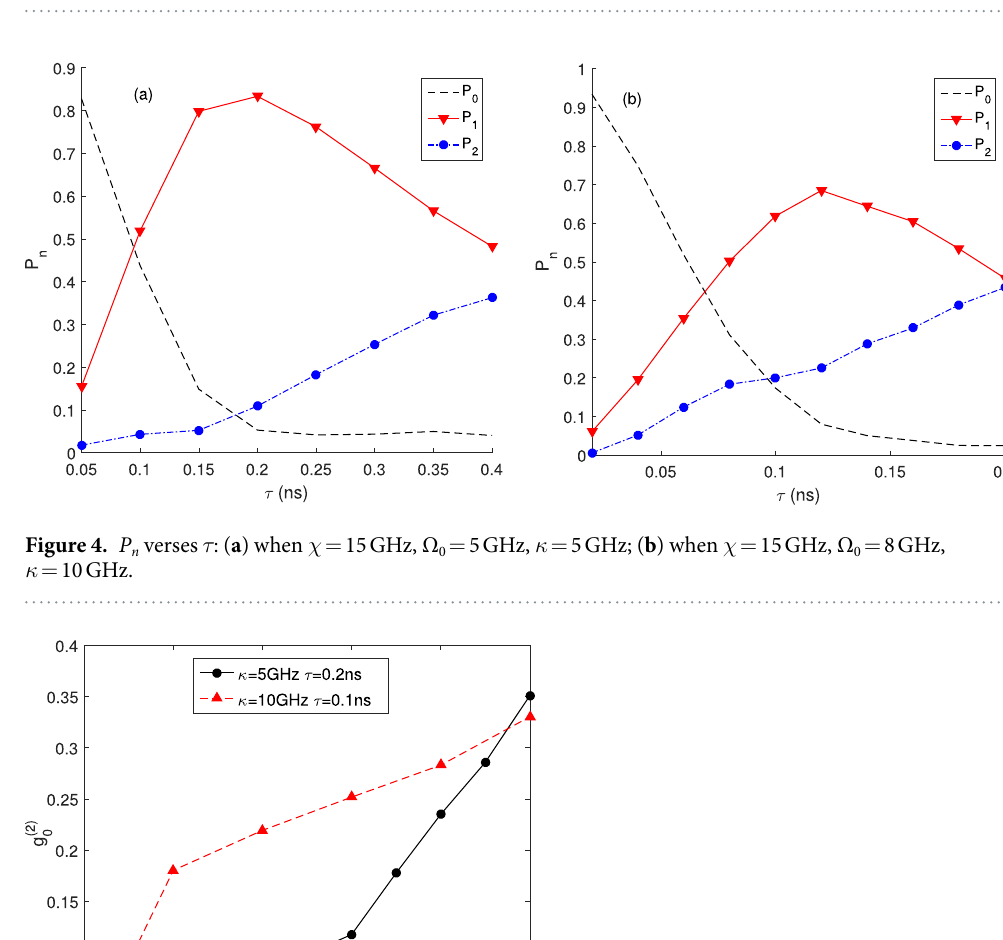
Figure 3. P 0 and P 1 verse τ κ Ω / 02